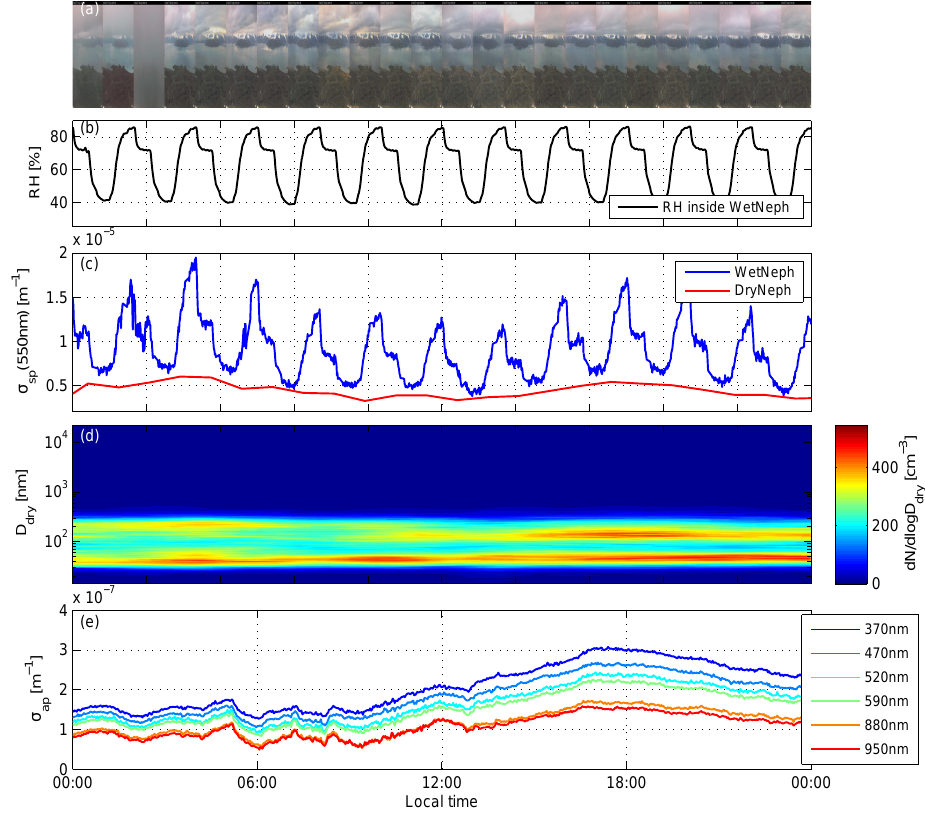
Fig. 2. Example of the recorded data for 20 August 2008 (local time). (a) : Hourly webcam pictures from Zeppelin station. (b) : Relative humidity inside the WetNeph. (c) : Measured scattering coefficients σ sp (λ = 550nm) in the DryNeph (red line, hourly averages) and in the WetNeph (blue line, 2min values). (d) : Number size distribution measured by SMPS and OPC. (e) : Absorption coefficient σ ap determined by the aethalometer at different wavelengths (one hour moving mean applied). The 660-nm channel was not working properly and had to be